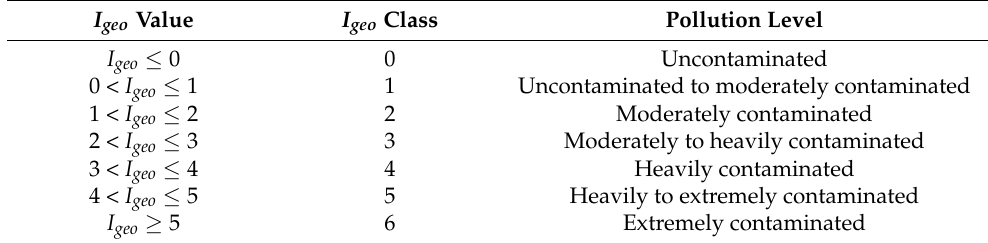
Table 2. Values of I geo and the pollution